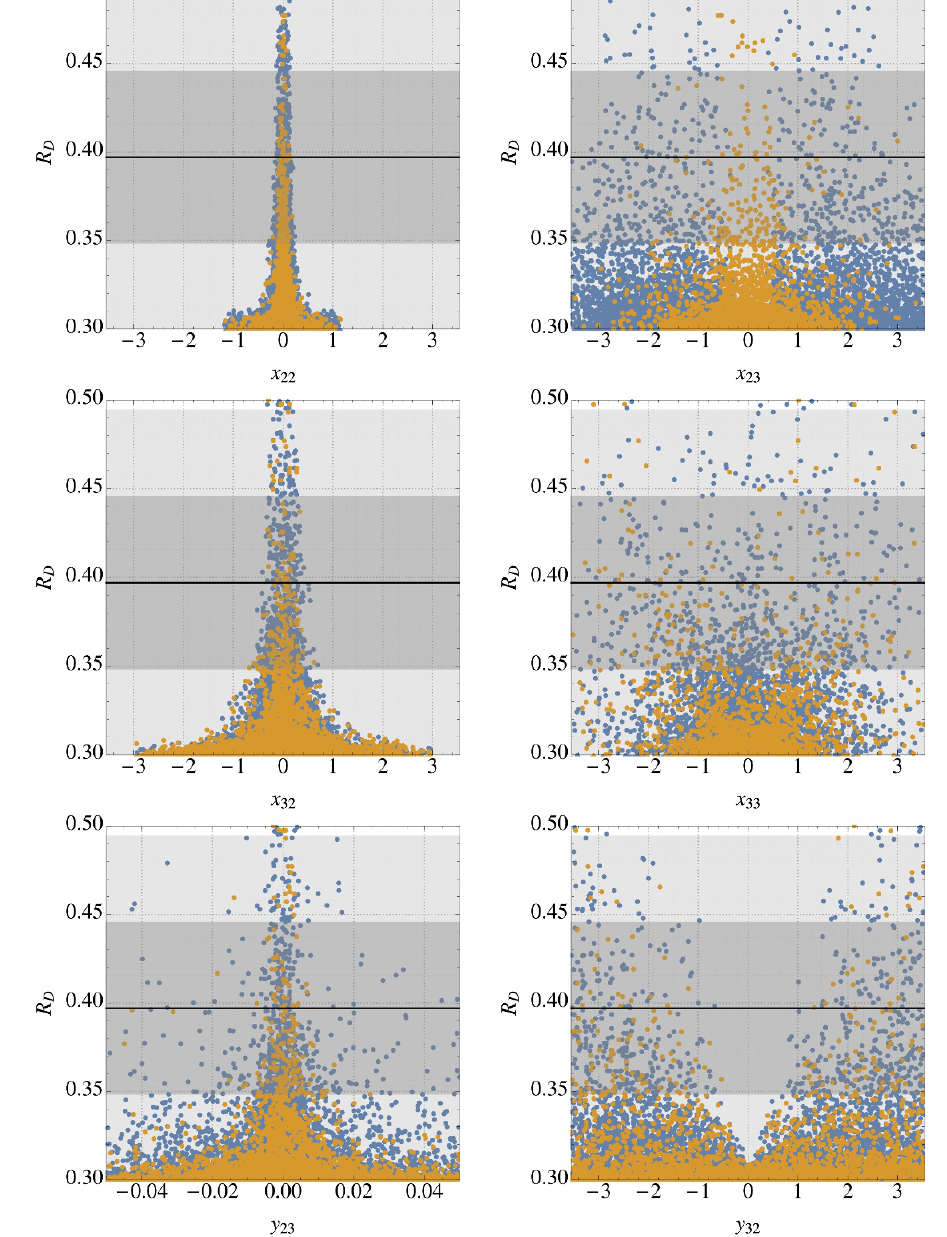
Figure 13. Slices through the parameter space of scan II. The solid black line represents the central value of the R measurement, and the grey bands correspond to the 1 and 2 (cid:27) regions. D The orange points keep C SM-like, while blue points show > 1% deviation in C LL prediction. Large values x 33 and y 32 are necessary for an adequate explanation of R feature in C and C . Other left-handed couplings must be small to evade constraints from R (cid:23)(cid:23) S T and B { (cid:22) B mixing. The results for R are qualitatively the same. s s D (cid:3)